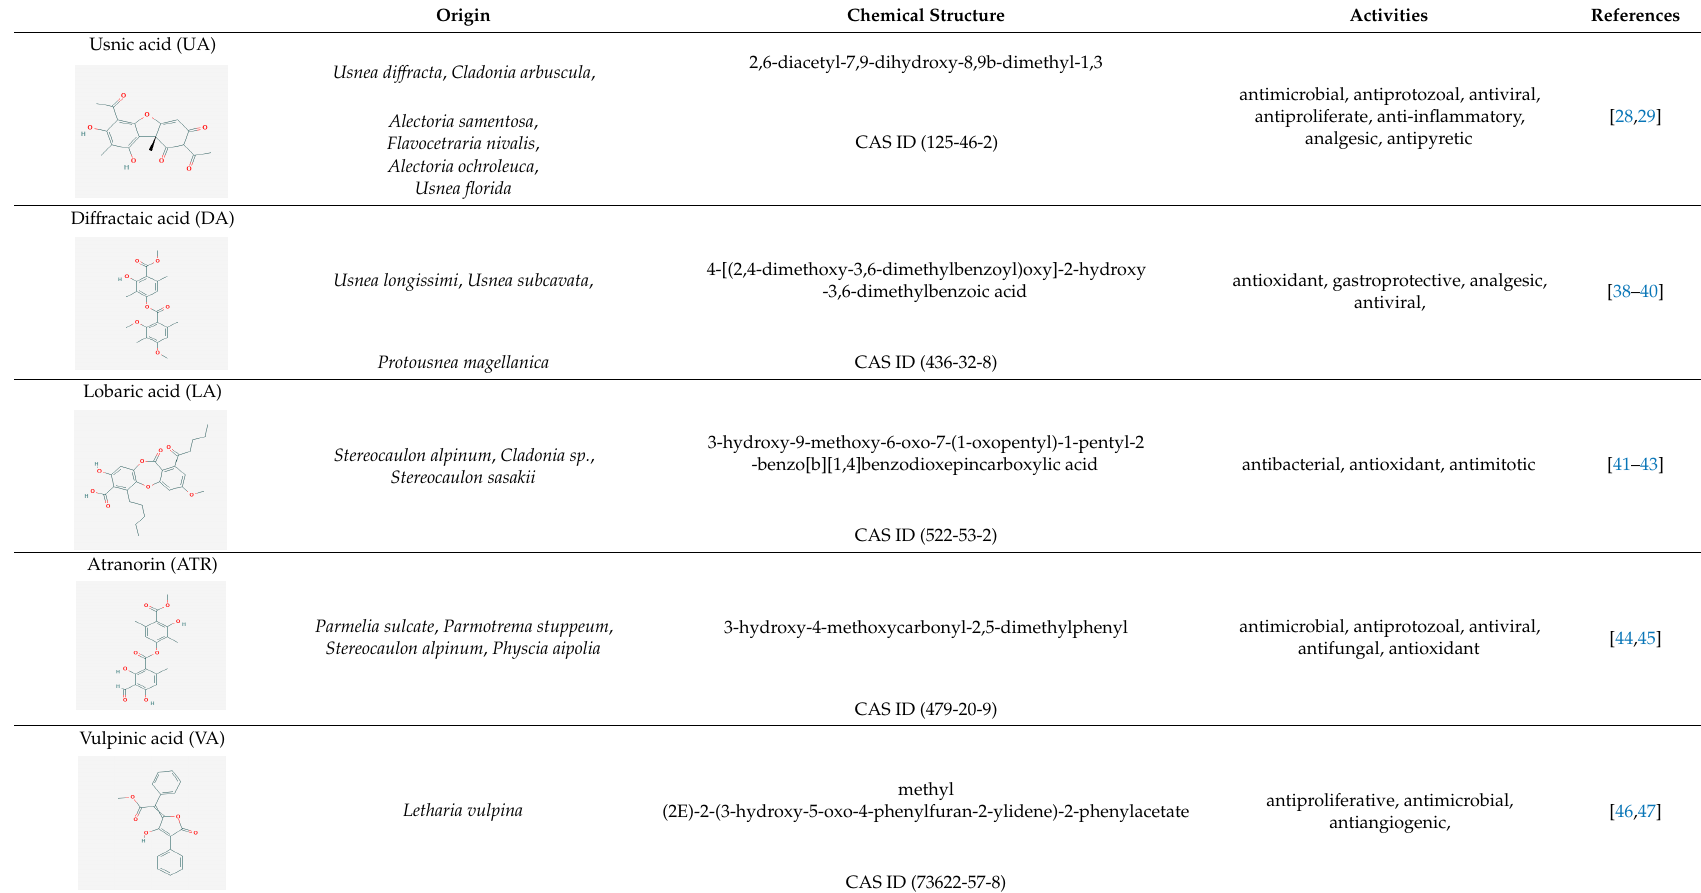
Table 1. Secondary metabolites of lichens, their origin, chemical structure and activities.